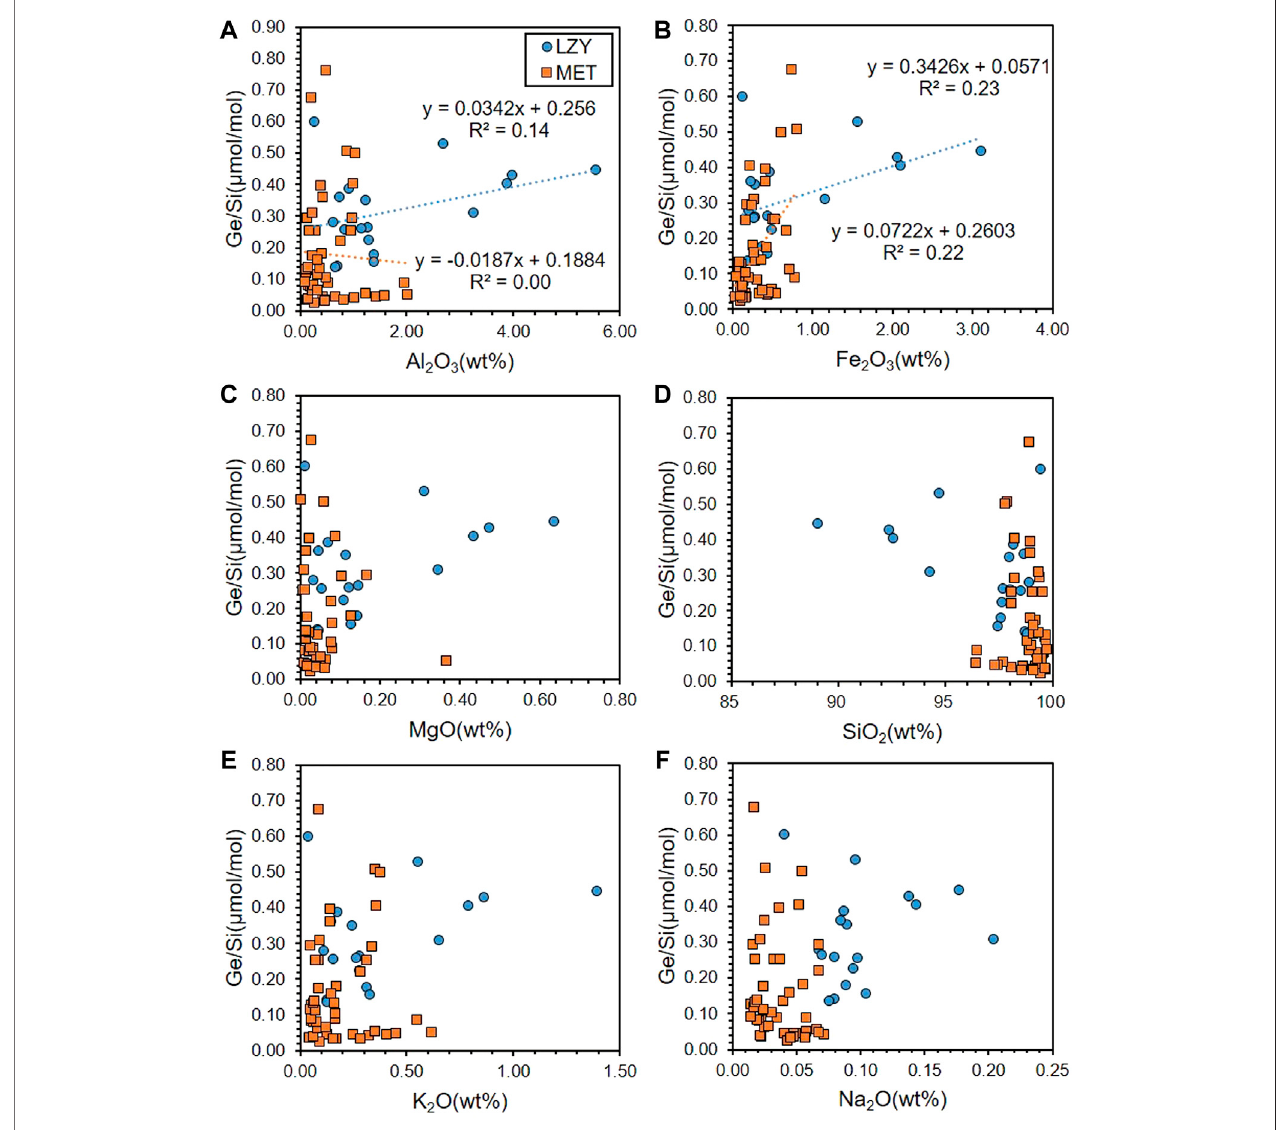
FIGURE 5 | Cross plots showing the correlations between Ge/Si ( μ mol/mol) and major element contents (measured as oxides in wt%). (A) Al 2 O 3 vs. Ge/Si; (B) Fe 2 O 3 vs. Ge/Si; (C) MgO vs. Ge/Si; (D) . SiO 2 vs. Ge/Si; (E) K 2 O vs. Ge/Si; and (F) Na 2 O vs. Ge/Si.